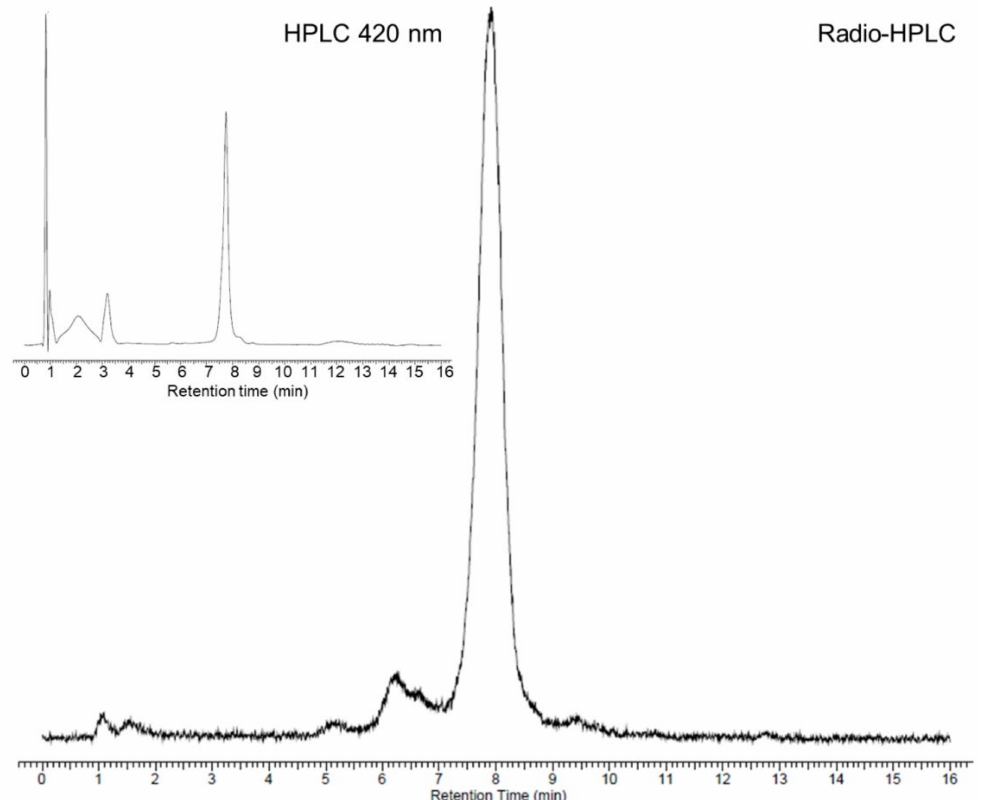
Figure 2. The radio-HPLC chromatogram of the radiolabeling solution after 15 min at 80 ◦ C. The retention time of the peak corresponding to [ 45 Ti]salan-Ti-CA-PSMA ([ 45 Ti]- 3 ) was 7.9 min. Insert: The UV signal at 420 nm of the HPLC chromatogram for the nonradioactive Salan-Ti-CA-PSMA ( 3 ). The retention time was 7.7 min. The time di ff erence is due to the radioactivity detector being placed after the UV